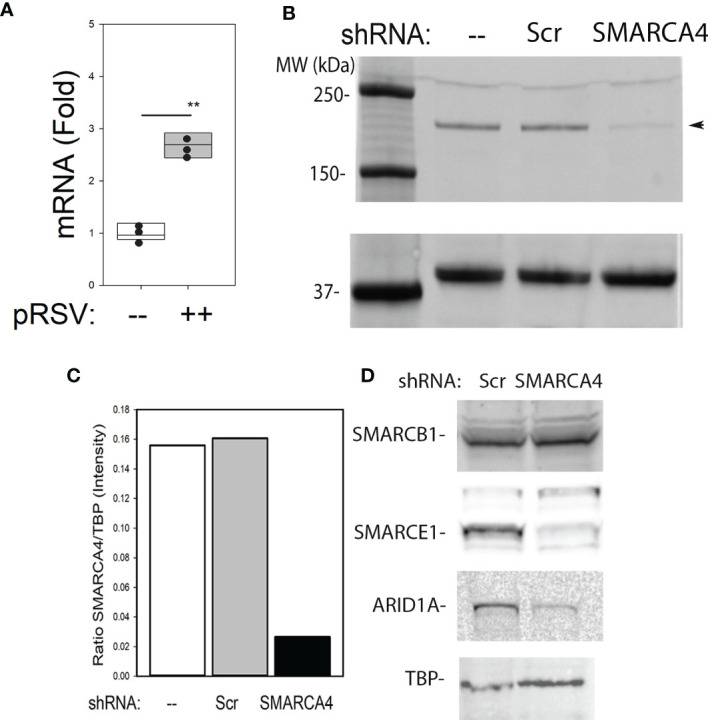
Induction and disruption of the SMARCA4 complex. (A) Wild type (WT) human small airway epithelial cells (hSAECs) were mock or pRSV infected (MOI=1). Q-RT-PCR was performed for SMARCA4 and PPIA mRNAs. Shown is fold change of SMARCA4 mRNA normalized to PPIA. **p < 0.01, 2 tailed T test. (B) Western immunoblot of SMARC A4 in WT, CON, and SMARCA4-shRNA expressing hSAECs. Left, molecular weight markers (in kDa). TATA binding protein (TBP) is internal control. (C) Quantification of individual western blot lanes in (B). Fluorescence intensity was quantified using ImageJ and presented as ratio of SMARCA4/TBP (arbitrary fluorescence units). Reproduced in three biological replicates. (D) Effect of SMARCA4 depletion on SWI/SNF core complex. Western blot of SMARCE1, SMARCB1, and ARID1A. TBP is internal loading control. Abundance of SMARCE1 and ARID1A were depleted by 50%, reproduced in n=3 experiments.